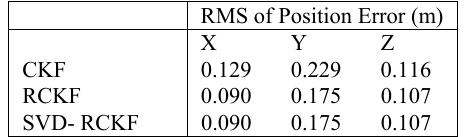
Table 2. Position errors of different filters in case